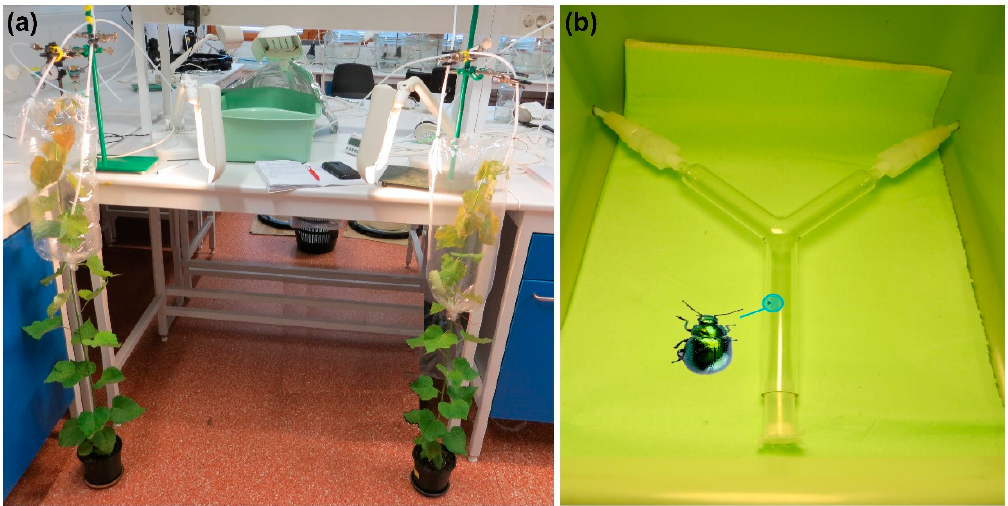
Figure 1. Olfactory bioassay illustration. ( a ) The entire experimental setup. ( b ) A closer look at the dual choice olfactory